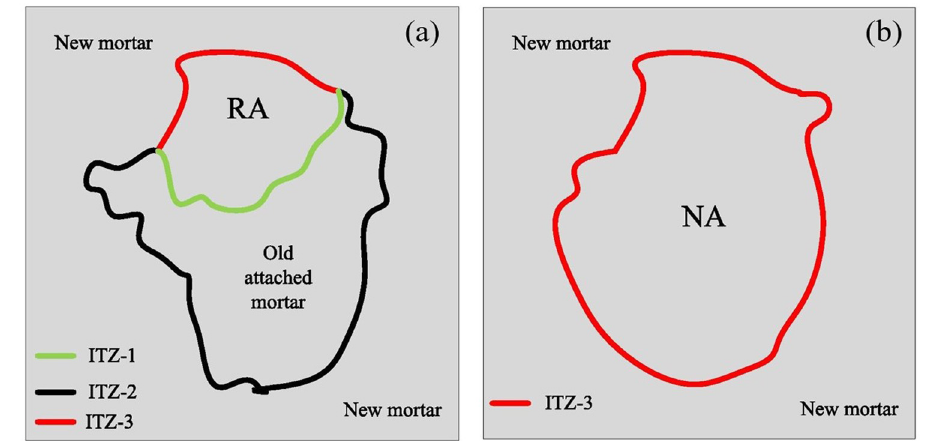
Figure 1: ITZ in concrete ( a ) ITZ s of RAC, ( b ) ITZ of NAC [ 16 ]